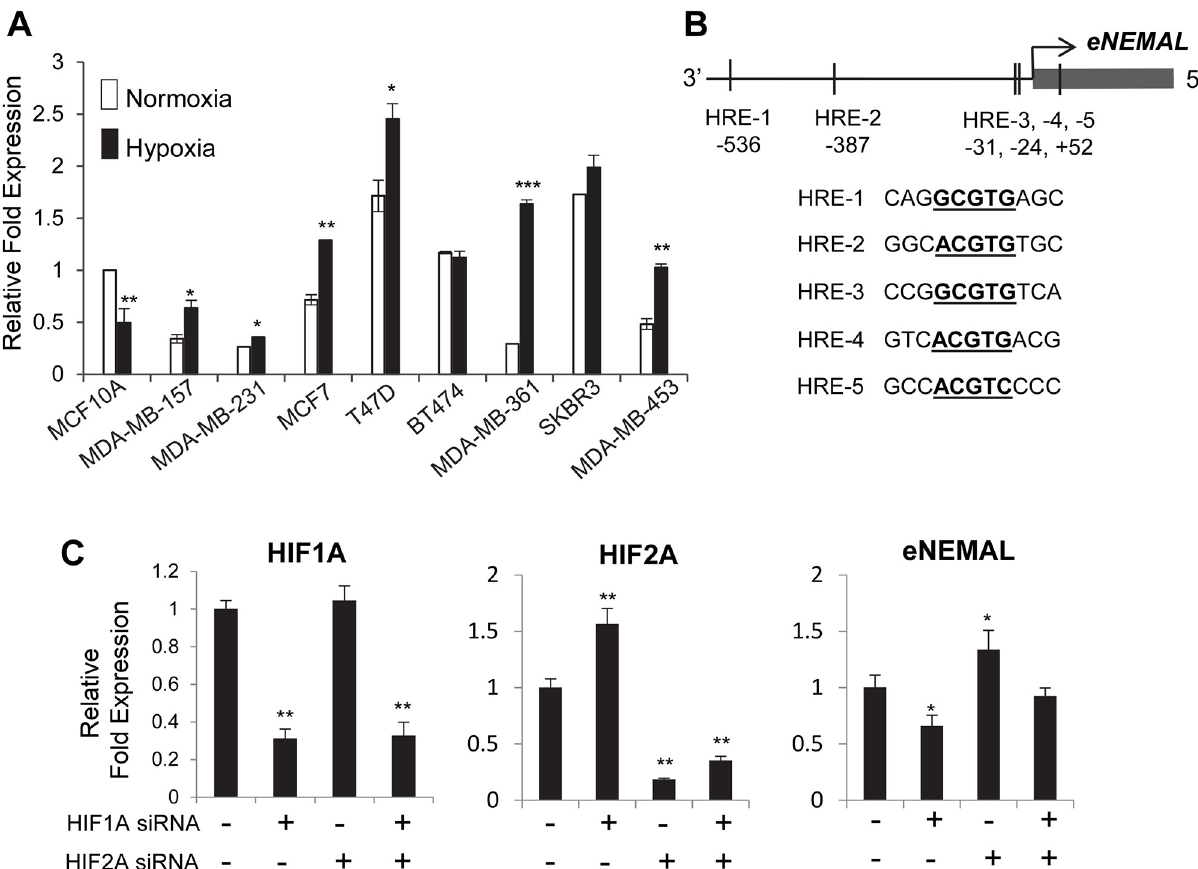
Fig 4. eNEMAL is upregulated under hypoxia in breast cancer cells. ( A ) eRNA expression determined by RT-qPCR following in cells grown under normoxic (21% O 2 ) and hypoxic (1% O 2 ) conditions for 24 hours, normalized to MCF10A normoxic expression. MCF10A, non-tumorigenic immortalized; MDA-MB-157 and MDA-MB-231, triple-negative; MCF7 and T47D, luminal A; BT474 and MDA-MB-361, triple positive; SKBR3 and MDA-MB-453, HER2-enriched. ( B ) Hypoxic response elements (HREs) in the eNEMAL promoter. ( C ) MCF7 cells were transfected with siRNA targeting HIF1A or HIF2A for 48 hours then maintained under hypoxia for additional 24 hours. The expression levels of HIF1A, HIF2A and eNEMAL were determined by qPCR. Note that we observed HIF2A upregulation upon HIF1A siRNA transfection, which is consistent with the previous finding of a repressive role of HIF1A on HIF2A expression [20]. Data shown as mean ± SD, n = 3, � P < 0.05, �� P < 0.01, ��� P <